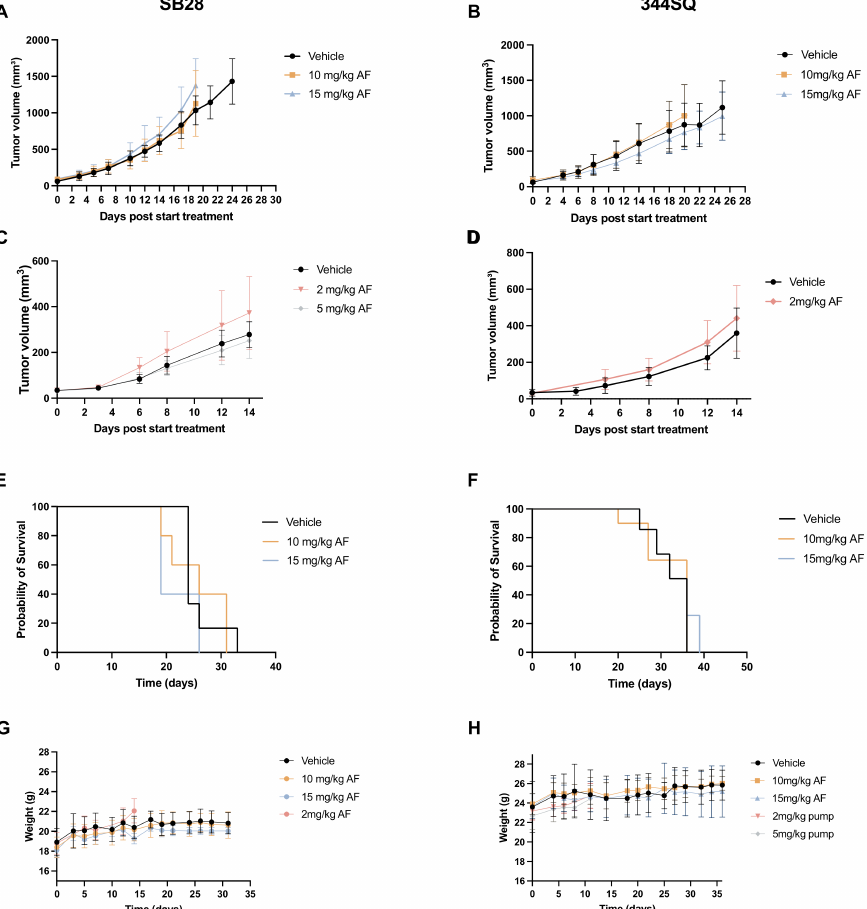
Figure 2. The effect of continuous delivery of low and high doses of AF using a subcutaneous (s.c.) osmotic minipump system on SB28 tumor-bearing C57BL/6J and 344SQ tumor-bearing 129-mice. ( A , B ) Tumor growth kinetics over time after 14 days of treatment with high doses of AF (10 or 15 mg/kg) delivered via a s.c. implanted osmotic minipump in SB28 C57BL/6J ( A ) and 344SQ 129 tumor-bearing mice ( B ). ( C , D ) Tumor growth kinetics after 14 days of treatment with low doses of AF (2 or 5 mg/kg) delivered via a s.c. implanted osmotic minipump in SB28 C57BL/6J ( C ) and 344SQ 129 tumor-bearing mice ( D ). ( E , F ) Survival of SB28 C57BL/6J mice ( E ) and 344SQ 129-mice ( F ) treated with high doses of AF via osmotic minipumps. ( G , H ) Body weight of SB28 C57BL/6J mice ( G ) and 344SQ 129-mice ( H ) after treatment with different doses of AF delivered via a s.c. implanted osmotic minipump. Data represent mean ± SD. N = 5 mice per